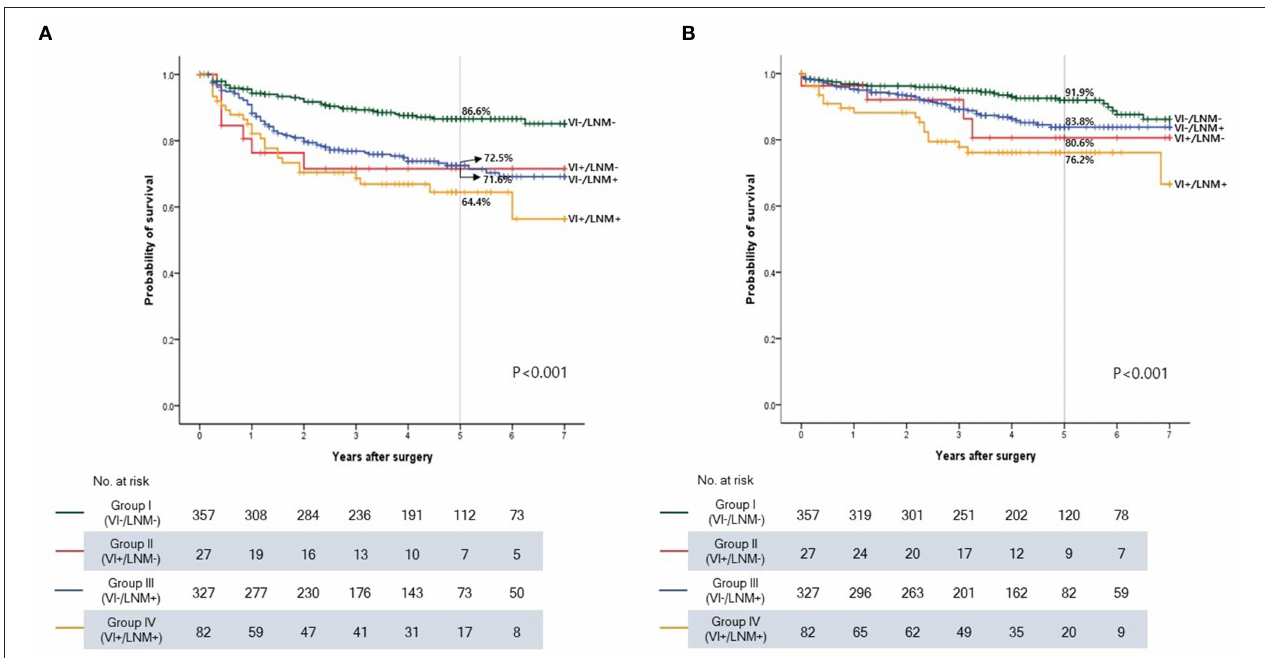
FIGURE 3 | Kaplan-Meier survival curve according to the groups in stage I-III colon cancer. (A) Disease-free survival. (B) Overall survival. VI, vascular invasion; LNM, lymph node metastasis.